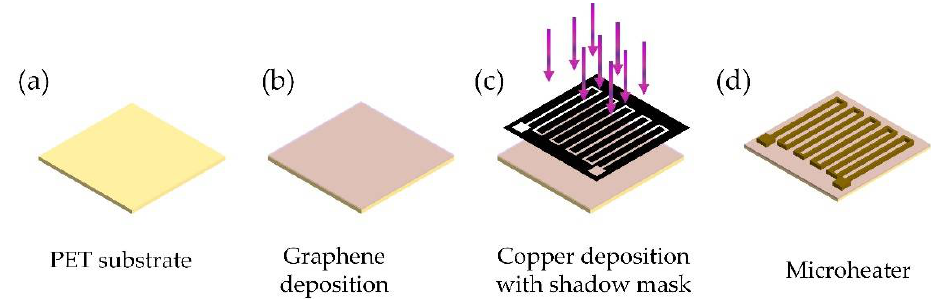
Figure 8. The feasible fabrication process flow for proposed microheaters, ( a ) PET substrate, ( b ) Graphene deposited with LPCVD, ( c ) Copper heating wire structure deposited with shadow mask, ( d ) The fabricated microheater.